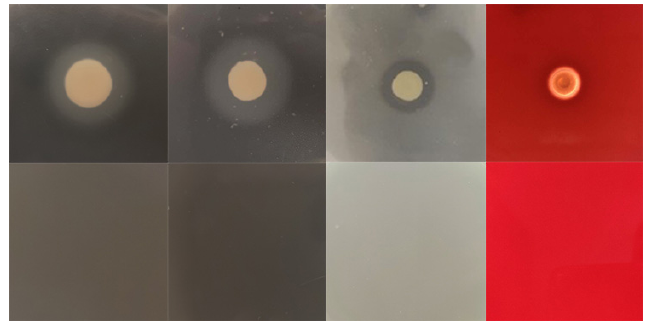
pase activity (Figure 5).